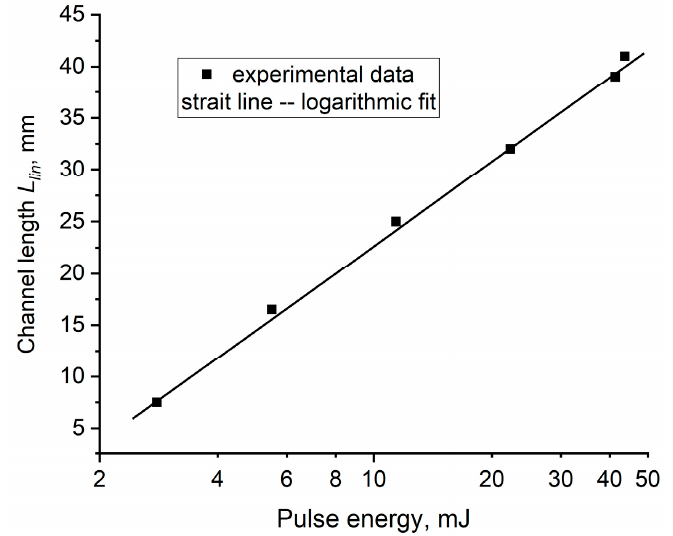
Figure 7. Channel length L lin in dependence on incident pulse energy.